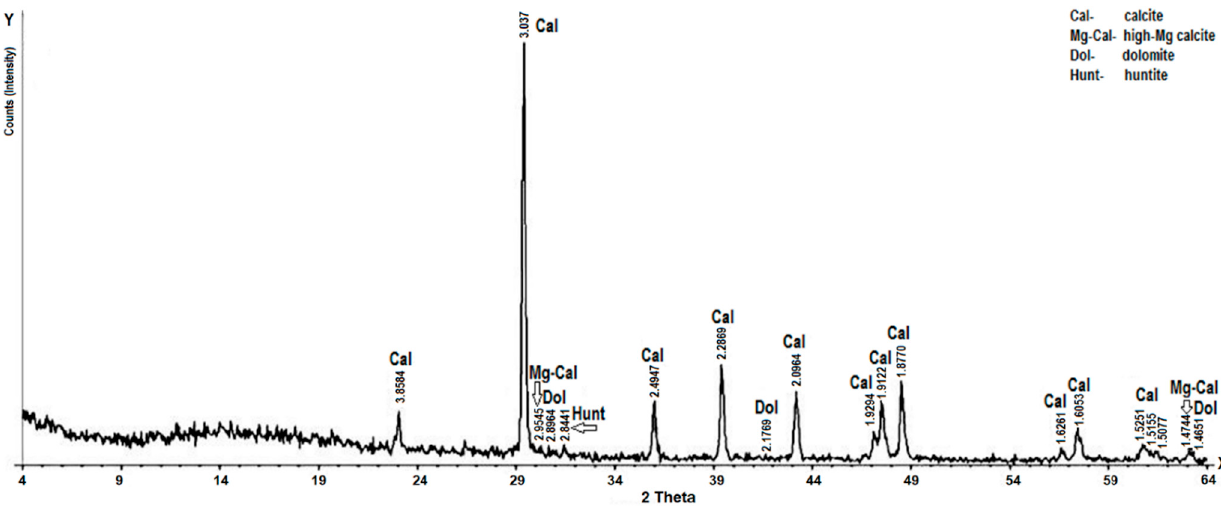
Figure 3. Diffractogram of sample W1, limestone of the Góra ż d ż e Unit taken in the Wysoka Quarry [24].